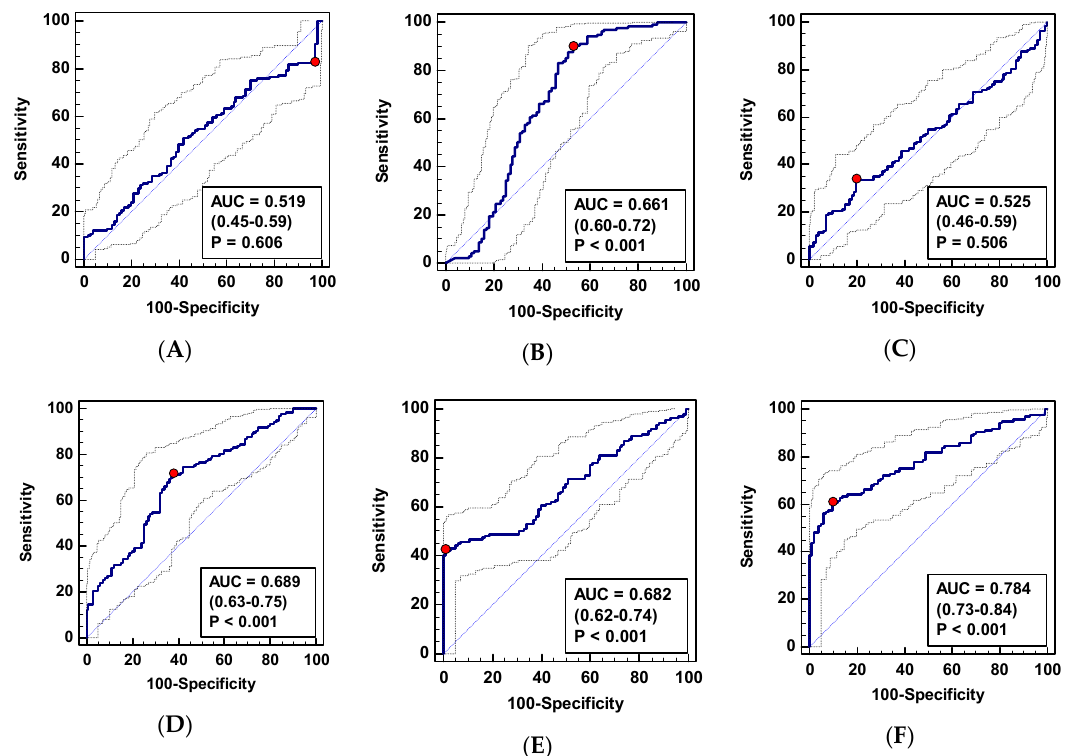
Figure 5. L-arginine/NO pathway metabolites as differential CRC biomarkers: ( A ) Arginine; ( B ) citrulline; ( C ) asymmetric dimethylarginine—ADMA; ( D ) symmetric dimethylarginine—SDMA; ( E ) dimethylamine—DMA; ( F ) metabolite panel consisting of SDMA, ADMA, and DMA. Data presented as receiver operating characteristic (ROC) curves with a 95% confidence interval ( CI ) and as an area under the ROC curve (AUC) with a 95% ( CI ) and significance of difference from AUC = 0.5, characteristic for a chance marker (represented as diagonal line). The red dot indicates Youden index. Table 9. Characteristics of L-arginine/NO pathway metabolites as differential CRC biomarkers. Marker Criterion Sens. and Spec. Youden ( J ) Index LR+ and LR-